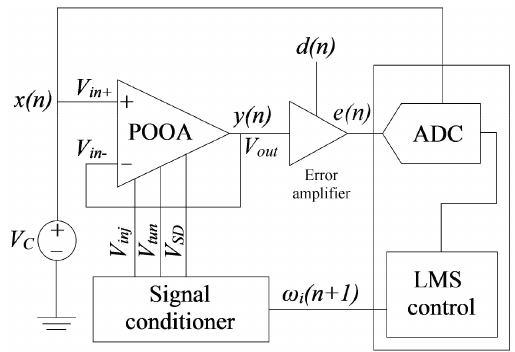
Figure 5. The POOA’s programming scheme based on LMS algorithm. The POOA is connected as a voltage follower in order to read the offset voltage directly. Because the offset voltage could be too small, an error amplifier is used. The ADC digitizes the error signal, so that the LMS control block is able to process